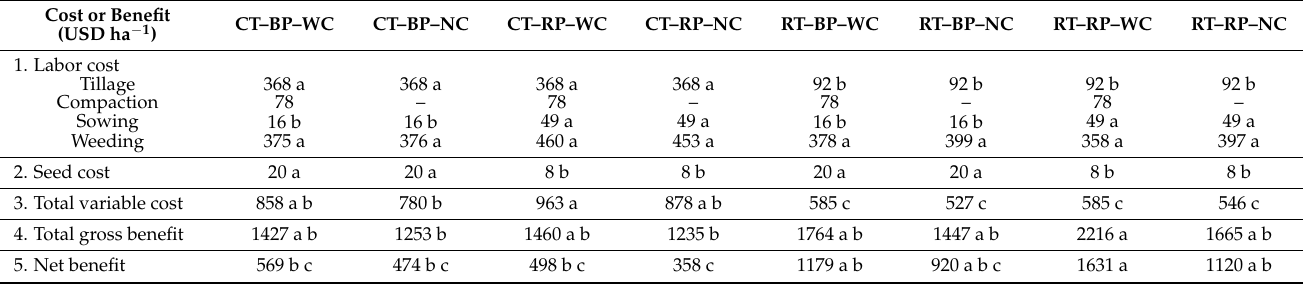
Table 7. Partial cost–benefit analysis for the different tillage, sowing, and soil compaction